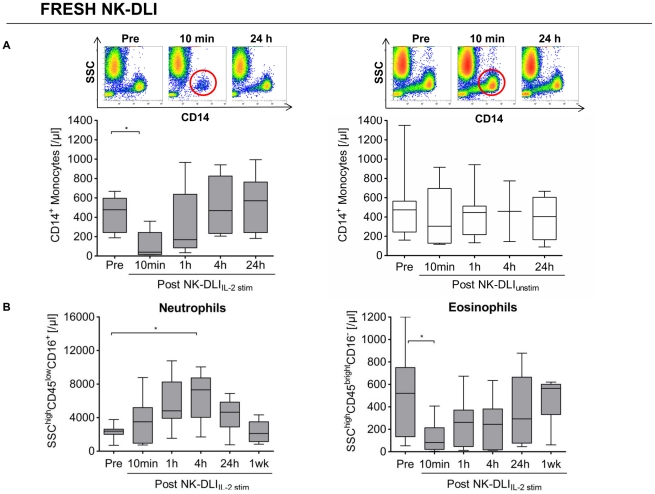
Influence of NK-DLIs on monocyte and granulocyte distribution in patient's PB.A) Significant reduction of absolute CD14+ monocyte count could be demonstrated in patient's PB 10 min after application of fresh NK-DLIIL-2 stim (n = 7), while recovering to normal values within the next 24 h. This was not seen after NK-DLIunstim (n = 6). Density plots show side scatter (SSC) vs. CD14 gated on CD45+ leukocytes. For the 4 h level post NK-DLIunstim 2 values were available, only. p<0.05 indicated as *. B) We observed a distinct influence of NK-DLIIL-2 stim on neutrophil and eosinophil granulocyte count. A massive increase of neutrophils (SSChighCD45lowCD16+) with its peak at 4 h was combined with a significant reduction of eosinophil granulocytes (SSChighCD45brightCD16−) in the PB after fresh NK-DLIIL-2 stim (n = 7). This was not observed after unstimulated NK cell applications (data not shown). p<0.05 indicated as *.